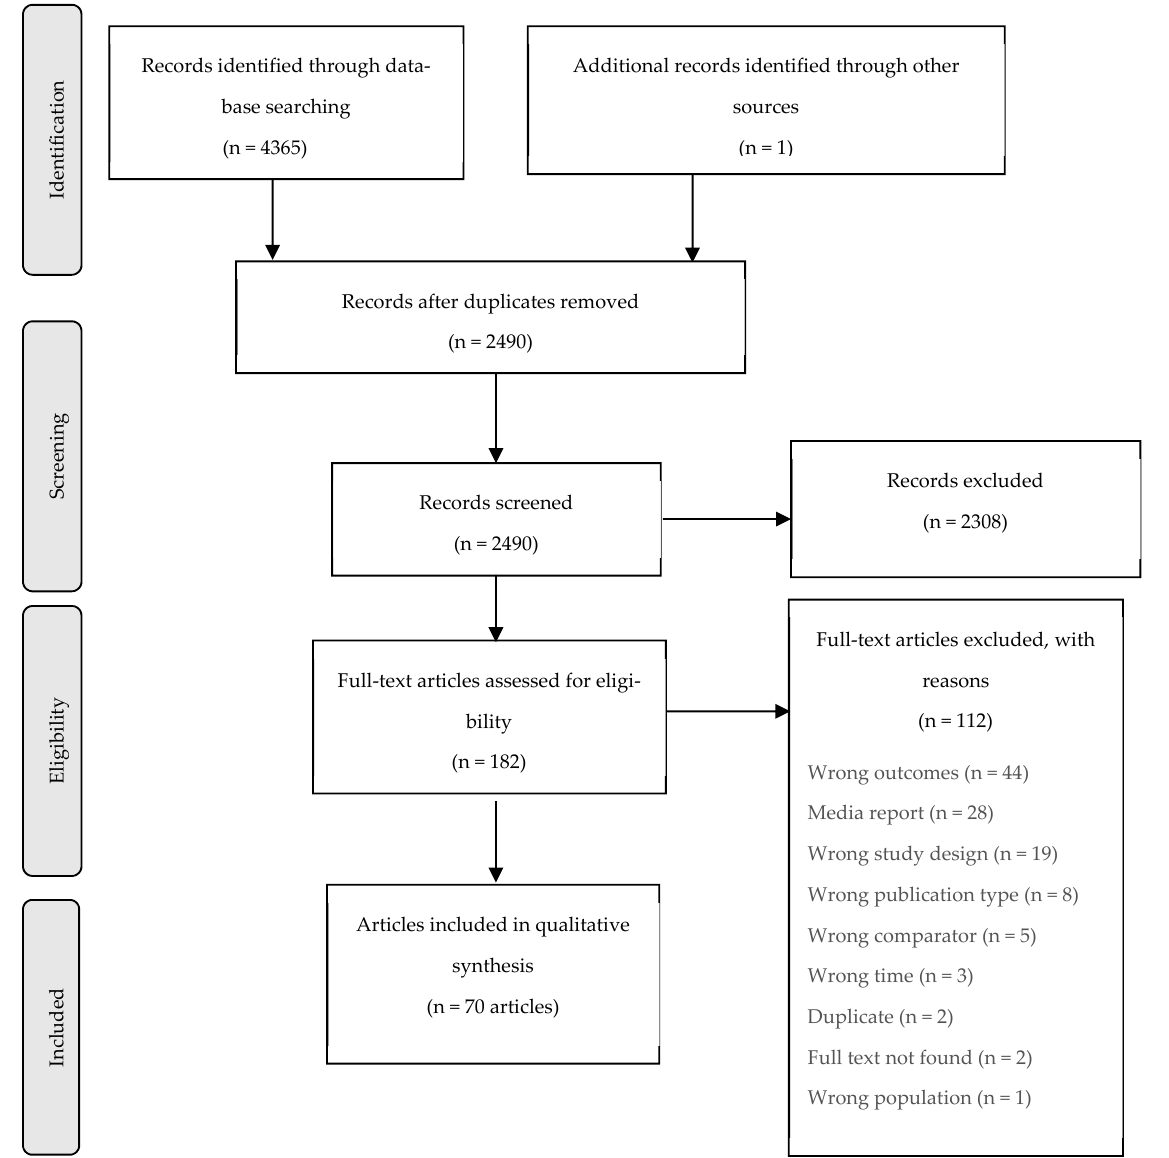
Figure 1. PRISMA flow diagram.